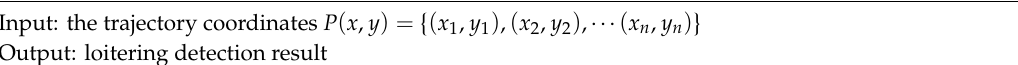
Algorithm 1: Rectangle loitering detection